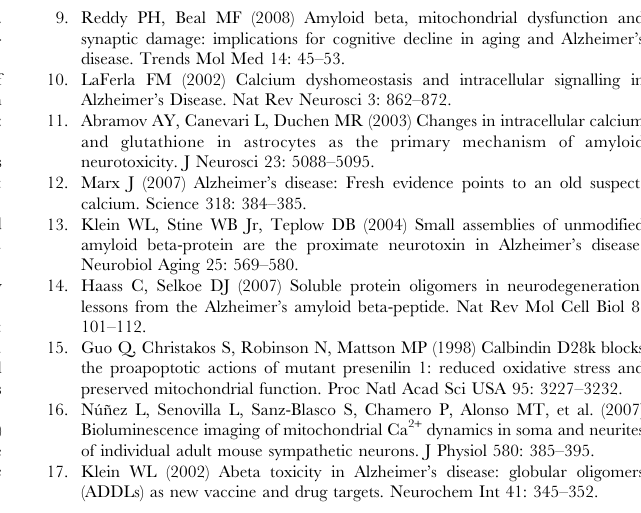
Figure S3 FCCP prevents the mitochondrial (but not the